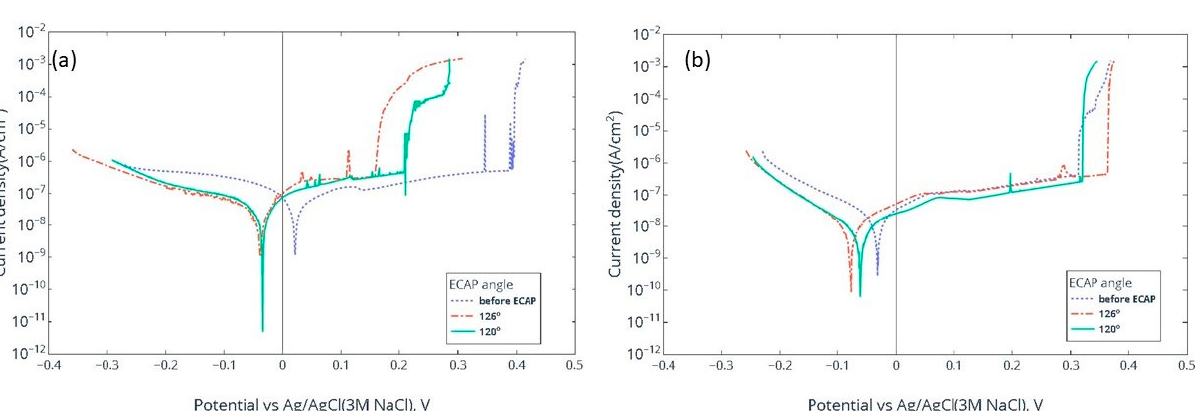
Figure 5. Comparison of the potentiodynamic polarization curves in ( a ) 0.9% NaCl and ( b ) E-MEM + 10% NCS. Table 1. Corrosion parameters of 316L SS before and after ECAP.